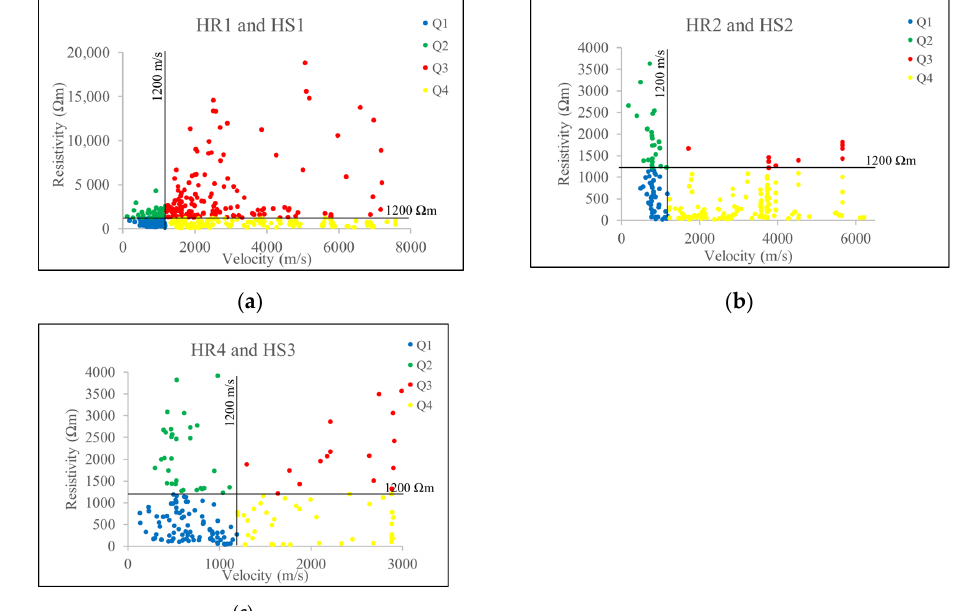
Figure 11. Graph correlation of resistivity–velocity for the same X–Y location for line: ( a ) HR1 and HS1; ( b ) HR2 and HS2; ( c ) HR4 and HS3. The 2-D cross-plot model was an enhancement work for cross-plot analysis in integrating different geophysical parameters. The goal of this work is to visualize and provide comprehensive subsurface images as well as to integrated both parameters of resistivity and velocity to be more precisely. In this study, the method was applied, and the final model of the 2-D cross plot was presented in Figure 12. Based on the previous discussion, this work was divided into three different stages of processing until the final data. Four quadrants were divided, representing four different characteristics of the subsurface, which are Q1 ( ≤ 1200 Ω m, ≤ 1200 m/s), Q2, ( ≥ 1200 Ω m, ≤ 1200 m/s), Q3, ( ≥ 1200 Ω m, ≥ 1200 m/s), and Q4 ( ≤ 1200 Ω m, ≥ 1200 m/s). The sorting analysis is applying to extract the values according to its depth and position that inline each other. Quadrant 1 (Q1) compromise of low resistivity and velocity values of ≤ 1200 Ω m and ≤ 1200 m/s respectively. From the preliminary results of 2-D resistivity and seismic refraction, this value plays as a threshold factor for the occurrence of landslides event. Figure 12a shows both 2-D resistivity and seismic refraction with a 2-D cross-plot model of line HR1 and HS1, as it was located outside the landslide boundary. From the 2-D cross plot model, the majority of the values dominate by quadrant four (Q4). The model shows the failure plane was identified at depth <5 m, dominated by the first quadrant (Q1), marked with a solid black line. In Q1, the region represents the highly weathered zone with lower resistivity and velocity values. This zone indicates the potential zone for mass movements or triggered zone for slope failure. The Q2 region at depth <5 m (solid rectangle box), shows low velocity and high resistivity values, which indicates the presence of moderate weathered material for this profile. The highest region represents by Q3 may indicate the presence of hard materials/boulder, which is aided as an additional factor for the occurrence of landslide, besides the movement of water flow due to saturated zones. The Q4 region dominates with a resistivity value of 1–1200 Ω m and a velocity of >1200 m/s. In Figure 12b,c, it shows the 2-D resistivity, seismic refraction, and 2-D cross-plot model for HR2 and HS2 and HR4 and HS3, respectively. As previously mentioned, this line was crossing the landslide boundary, which is generally the top surface cover with landslide material. From 2-D resistivity results, the saturated and highly weathered zones were identified at a resistivity value of <100 Ω m and 100–1200 Ω m, respectively. The seismic refraction profile shows the same characteristics where a low velocity zone identifies with a velocity of <1200 m/s. This zone mostly probably covers with loose material, such as sand with depth <5 m, as shown in the 2-D cross-plot model. The model reveals, at a depth of <5 m, the layer dominated with values from Q1 region, which classified as low velocity and resistivity values, indicating poorly compacted soil or the existence of higher porosity material, such as sand. The Q4 region looks dominant for this profile, which indicates the weathered zone; the region of Q2 at a depth of <5 m (solid rectangle box) shows low velocity but high resistivity, and may indicate the presence of a boulder at shallow subsurface, or represent as moderate weathered material for this profile. The Q3 region, with high resistivity and velocity, may